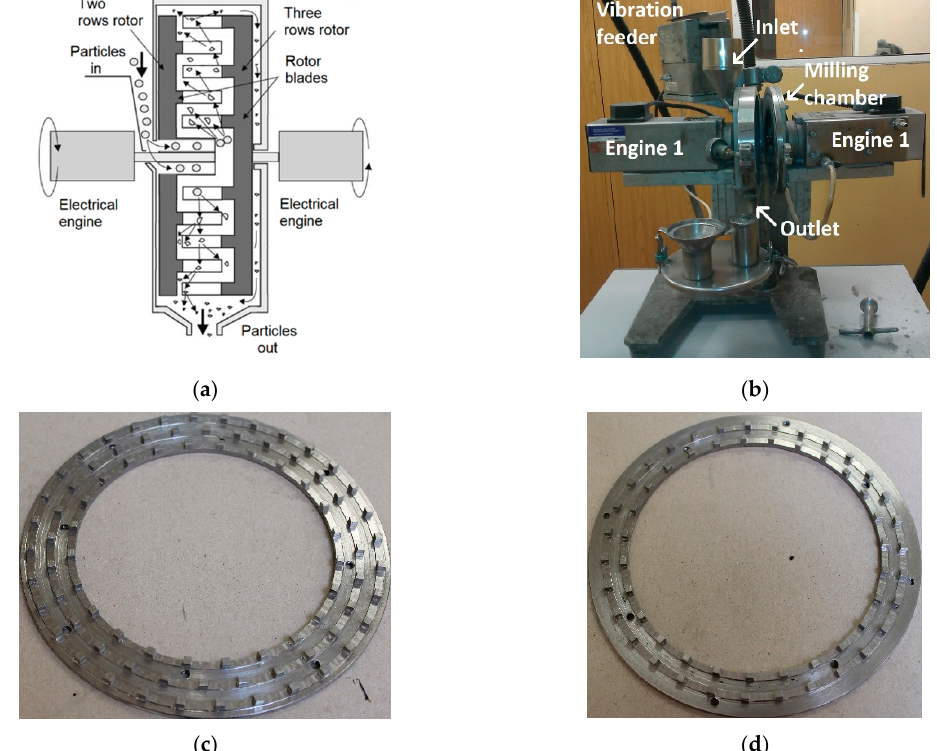
Figure 1. ( a ) Schematic depiction of the investigated disintegrator; ( b ) laboratory DESI 11 HSG mill ( c ) rotor with three rows of pins; ( d ) rotor with two rows of